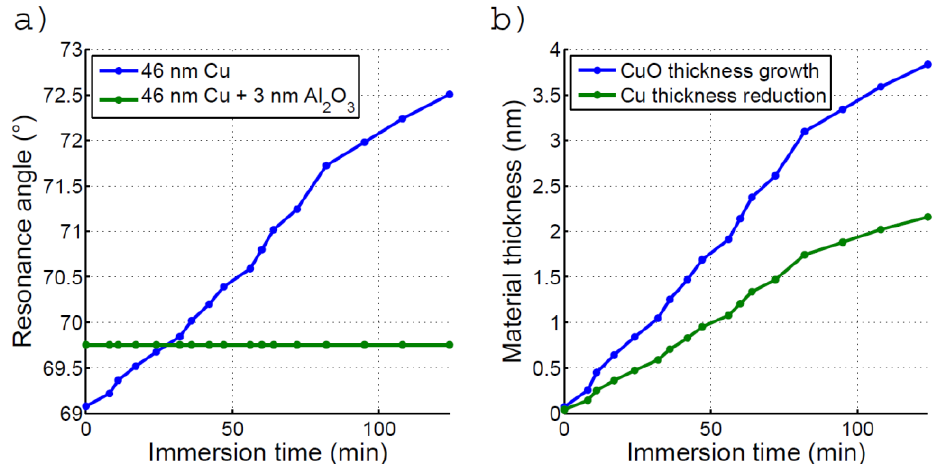
Figure 4. ( a ) Time evolution of the resonant angle for ( a ) the bare Cu thin film on glass and ( b ) the Cu thin film protected with 3nm of oxide, ( b ) Evolution of the CuO oxide growth at the bare Cu surface (in blue) and the corresponding reduction of the Cu metal (green) determined from the resonant angle change.